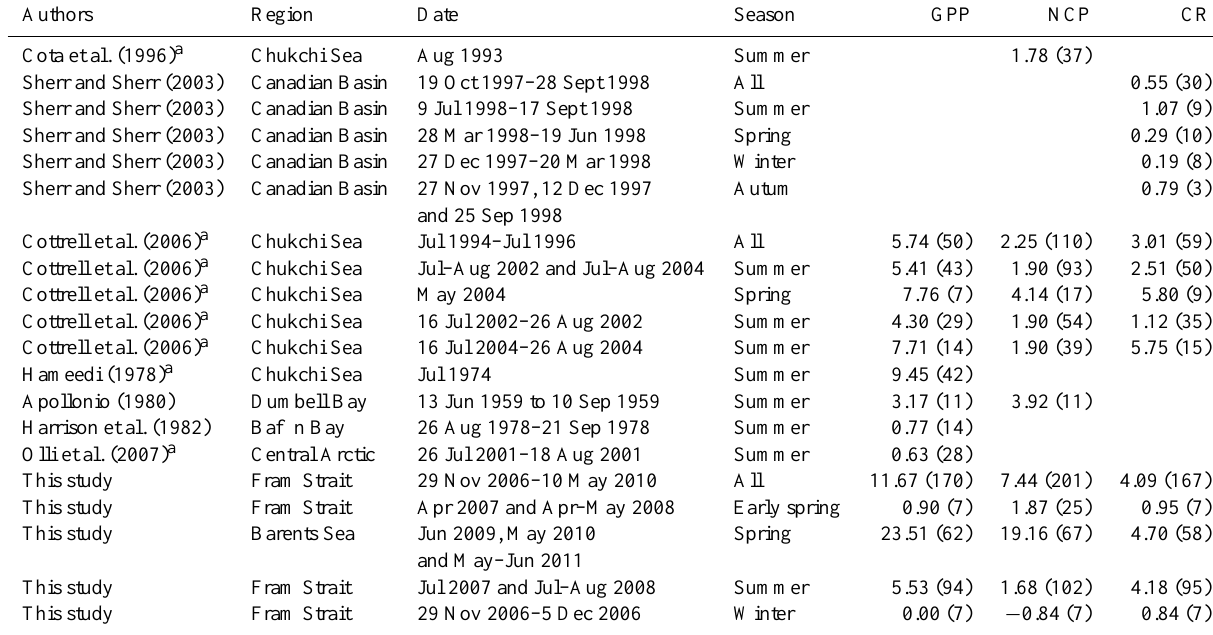
Table 3. Average planktonic metabolic rates (mmolO 2 m − 3 d − 1 ) for different studies of planktonic community metabolism in the Arctic Ocean. Rates given as gross primary production (GPP), net community production (NCP) and respiration ( R ). Number of measurements included for each rate is given ( N